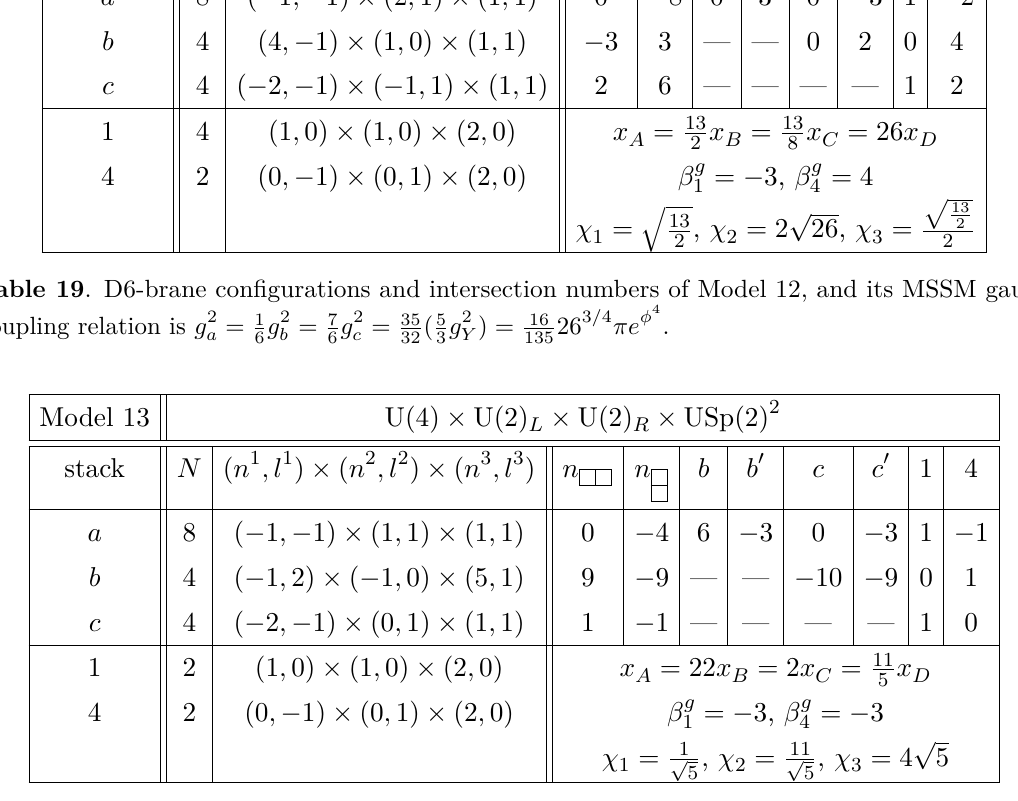
Table 20 . D6-brane configurations and intersection numbers of Model 13, and its MSSM gauge